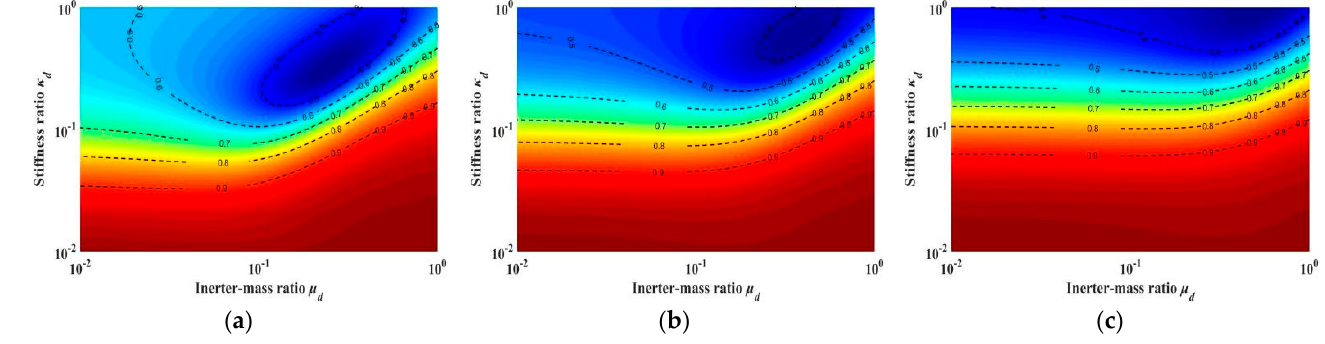
Figure 10. 2D Contour plot of γ Ur of EC system: ( a ) ζ d = 0.05; ( b ) ζ d = 0.10; and ( c ) ζ d = 0.15.